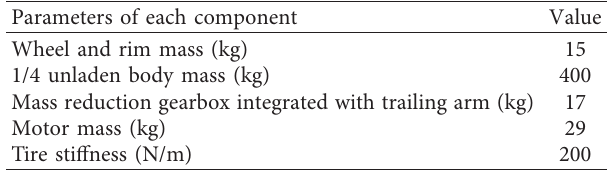
Table 6: Component parameters of the integrated E-type multilink suspension wheel-side drive